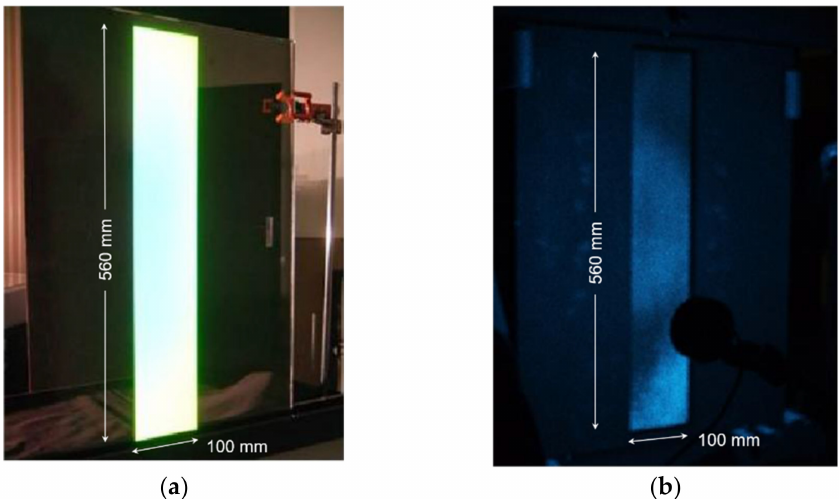
Figure 6. ( a ) The view into the B-HOE from the position of the focal position of the real image of the diffusor (phase-conjugated reconstruction). ( b ) The view into the BS-HOE, a two beam reflection copy of the B-HOE. Recording was performed with 0.647 µ m and 0.488 µ m simultaneously and the reconstruction was performed with 0.488 µ m